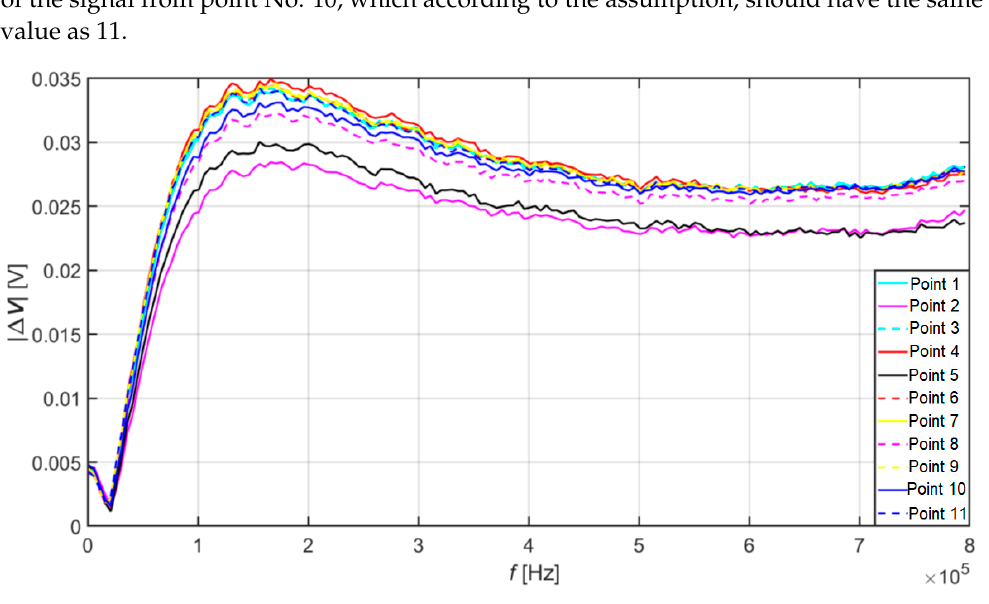
Figure 5. Graph of the absolute value of the voltage phasor of Specimen 1 corrosion crack. Figure 6 represents the absolute value of the phasor voltages measured in Specimen